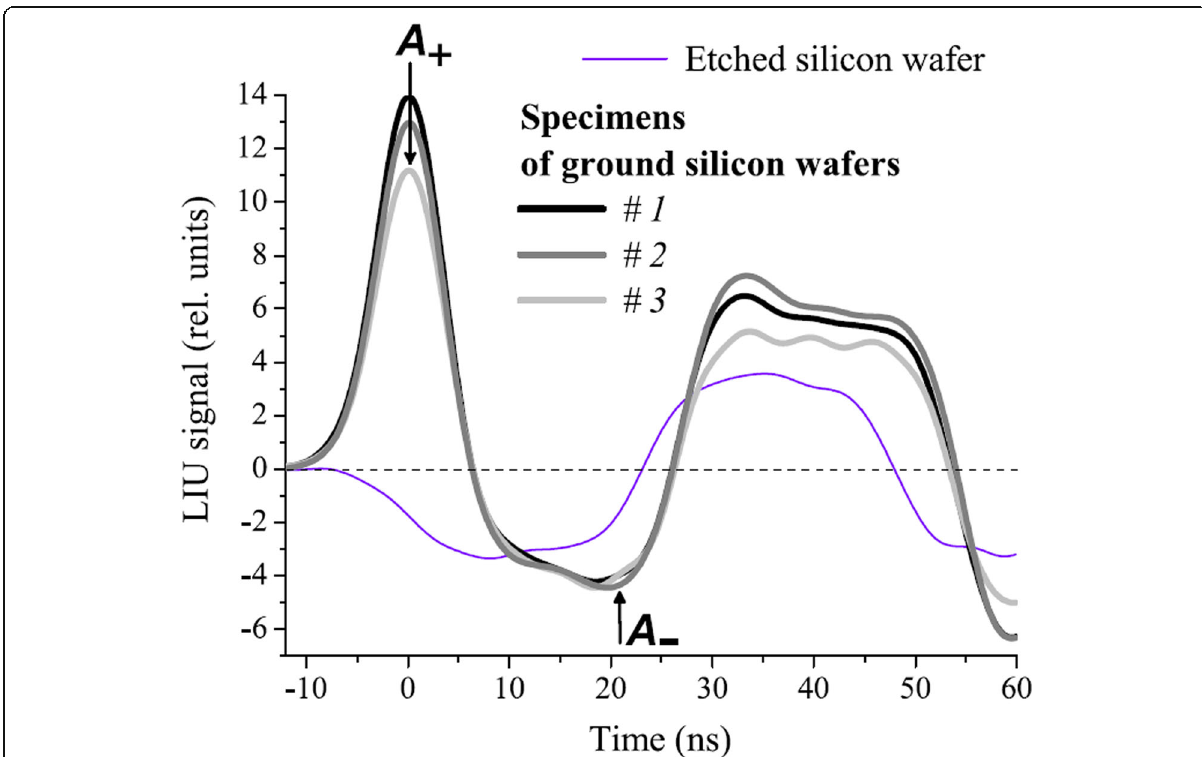
Fig. 5 One representative application of silicon using PA technologies for NDT/E: PA A-line signals in ground silicon wafers with different damage depth [37]. The measured values of A + and A − can be used to determine the subsurface damage depth. LIU signal, laser-induced US signals (i.e., PA